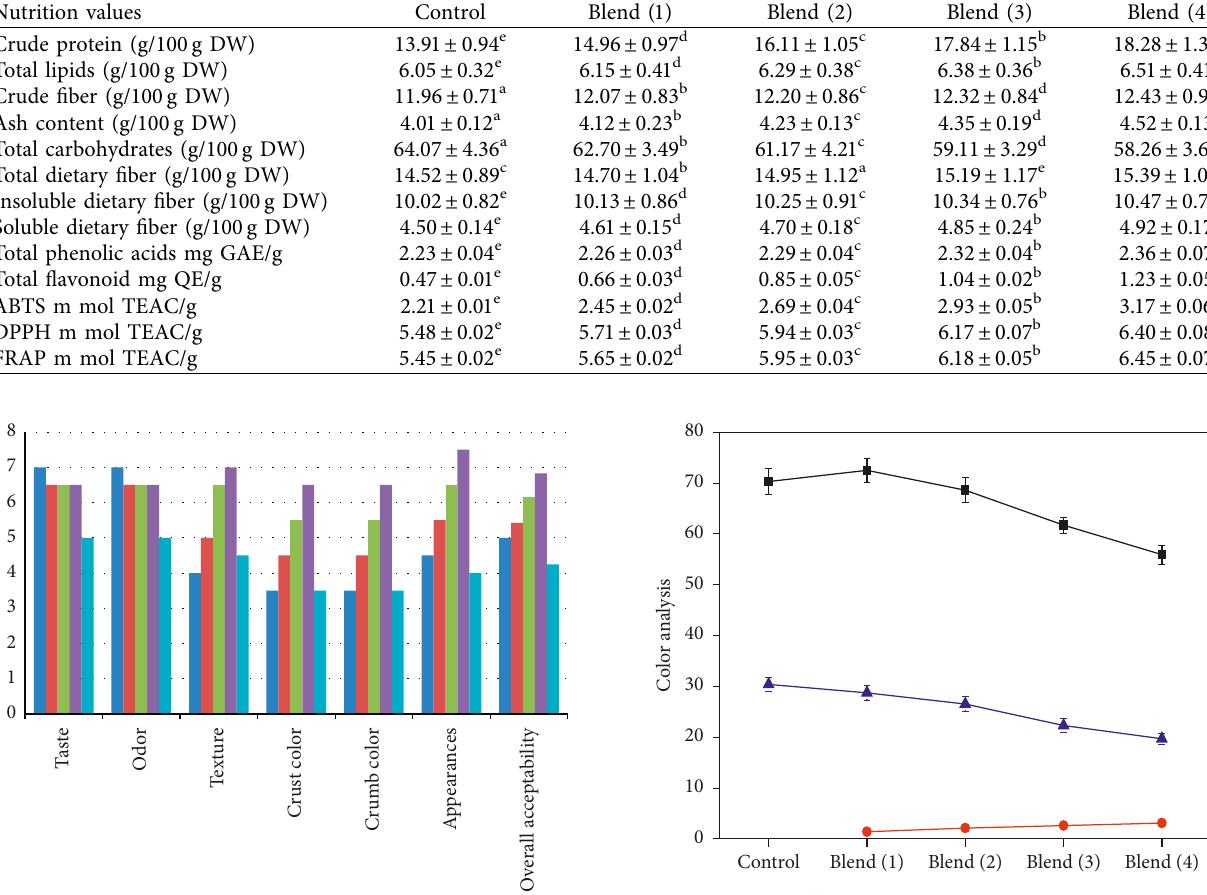
Table 4: Nutrition values of different blends of pan bread on DW.